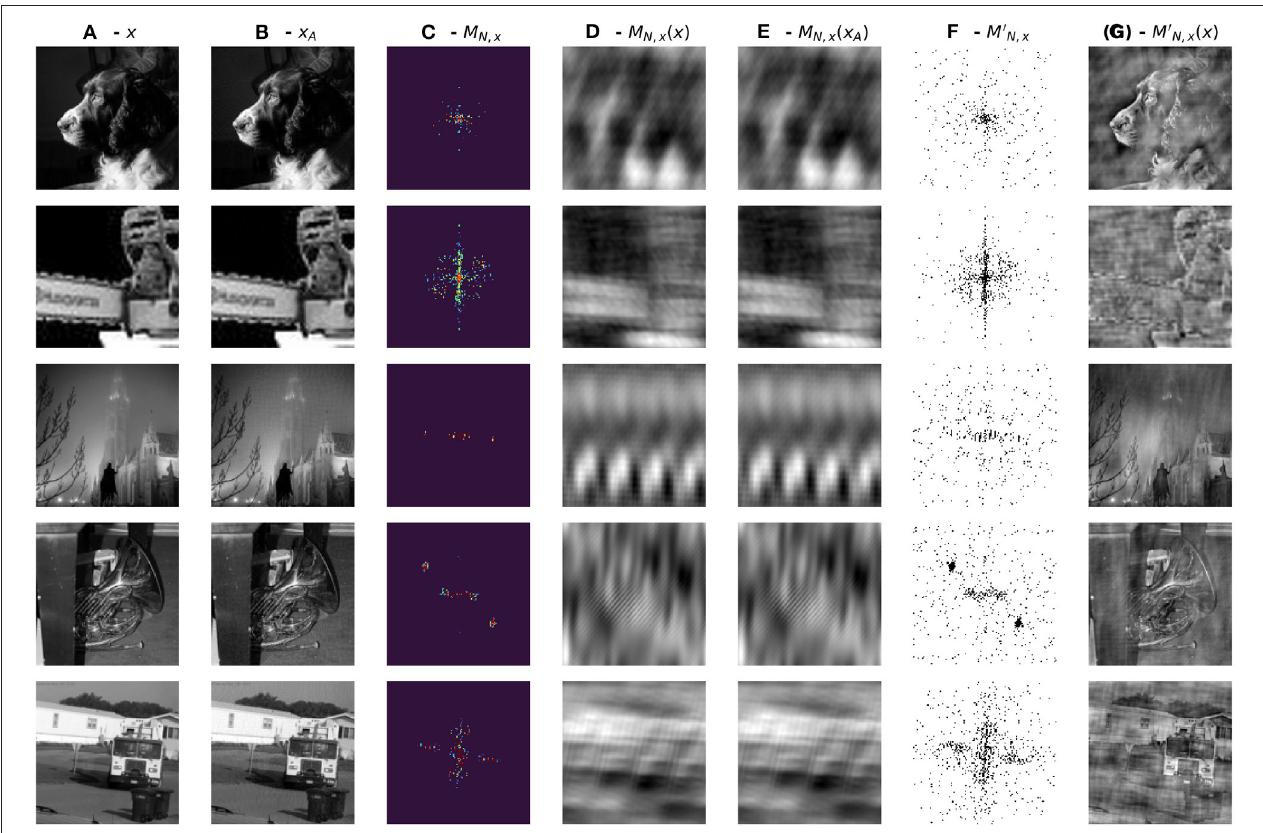
FIGURE 6 | (A) Correctly classified image x ∈ X V ; (B) Adversarial Image x A ; (C) M N , x - learned mask from vanilla network; (D) M N , x - filtered image x ; (E) M N , x - filtered image x A ; (F) M c N , x - binary complement of M N , x ; (G) M c N , x - filtered image x .